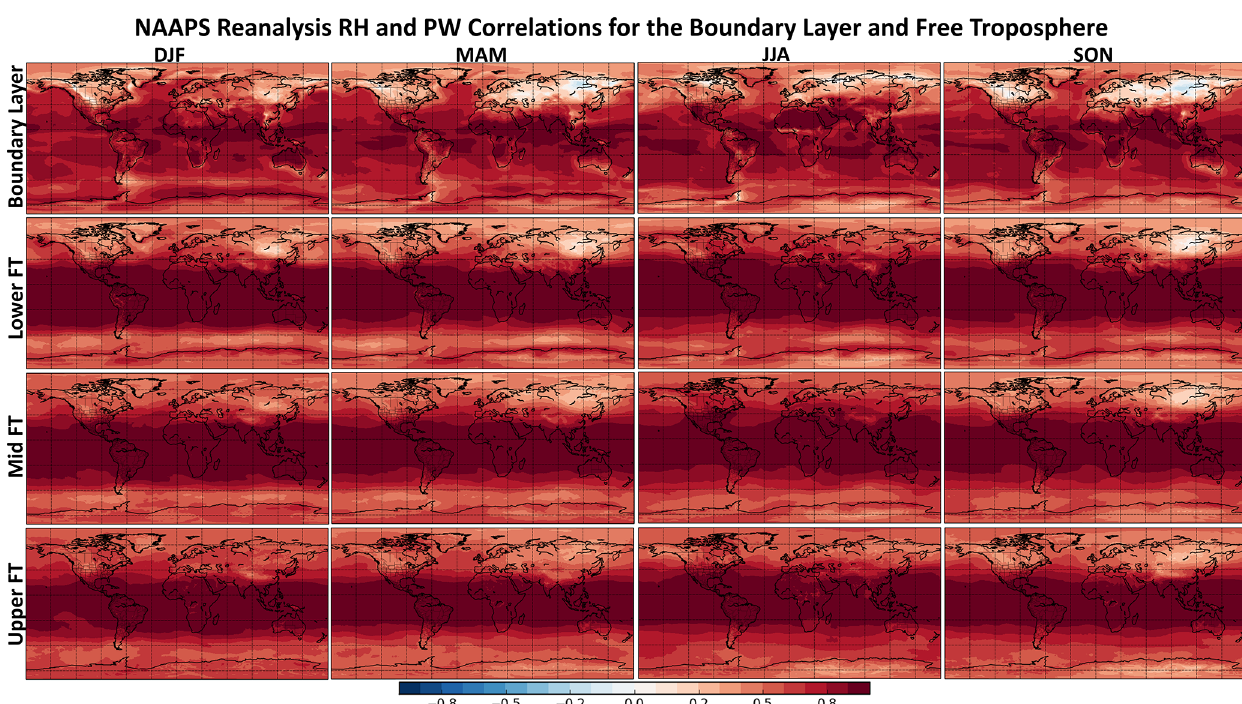
Figure 13. NAAPS-RA seasonal correlations (DJF, MAM, JJA, SON) between vertically integrated relative humidity (integrated specific humidity divided by the integrated saturation specific humidity) and specific humidity in the boundary layer, lower free troposphere, middle free troposphere, and upper free